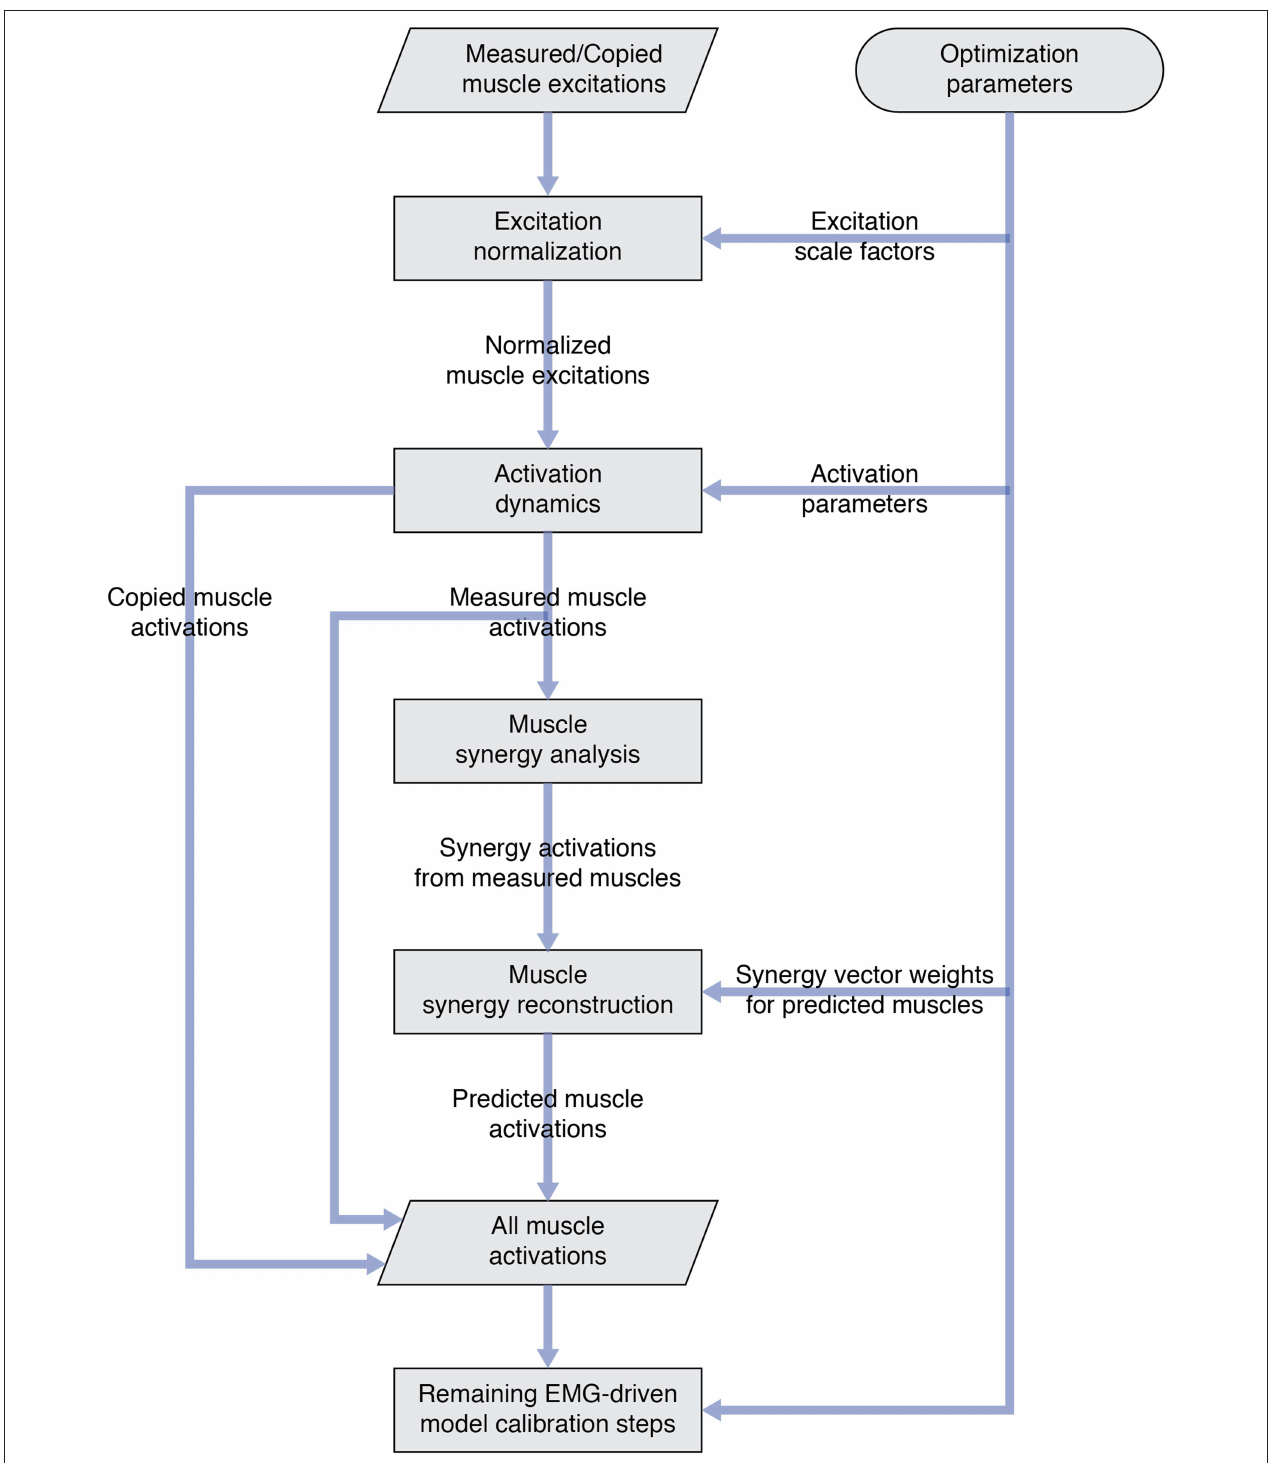
FIGURE 1 | Flowchart showing modifications to the original EMG-driven model personalization process to accommodate muscles with missing EMG signals. Two new steps—“Muscle synergy analysis” and “Muscle synergy reconstruction”—were added to the existing process to predict missing muscle activations whose shapes were consistent with synergy activations extracted from muscles with measured EMG